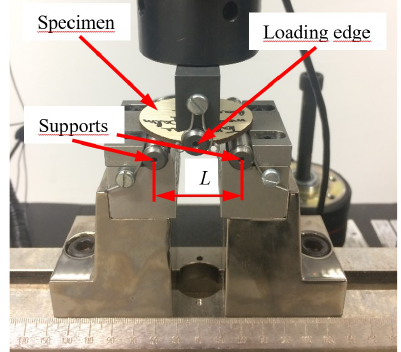
Fig. 4. Test scheme for a three-point flexural test